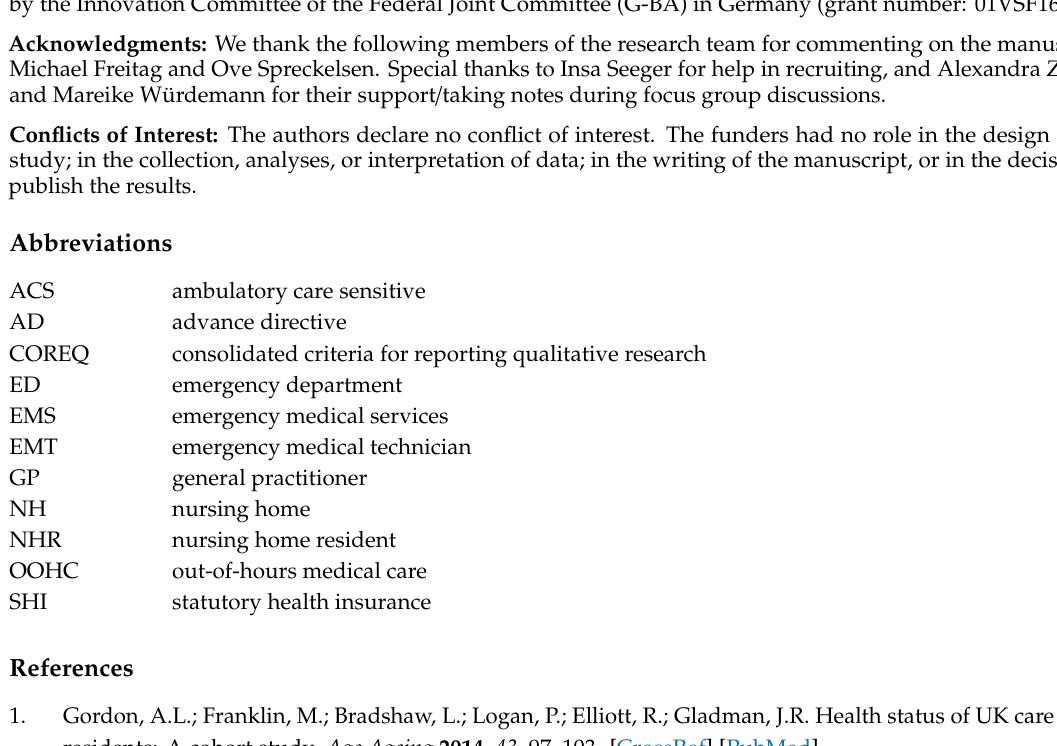
Table S1: Focus group question